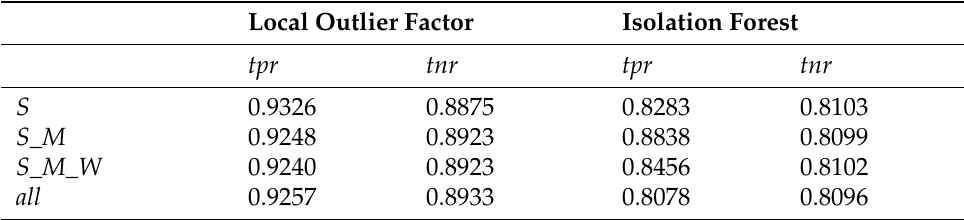
Table 16. Extended PaySim dataset outlier detection based fraud